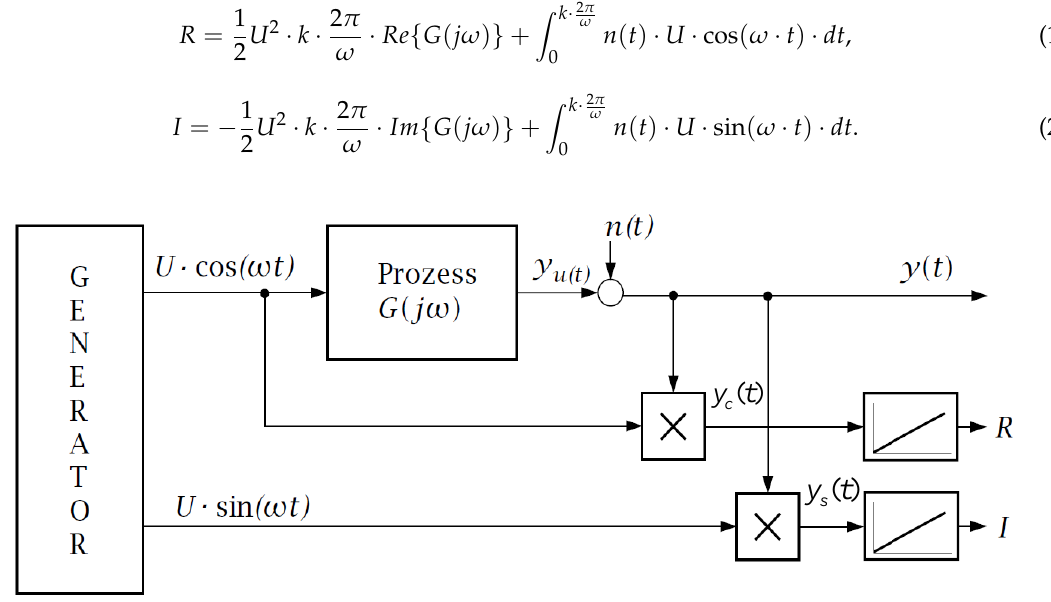
Figure 1. Action-diagram of correlation analysis used during impedance spectroscopy for determination of the real and imaginary parts of the transfer function (TF) for the discrete angular frequency 𝜔 .